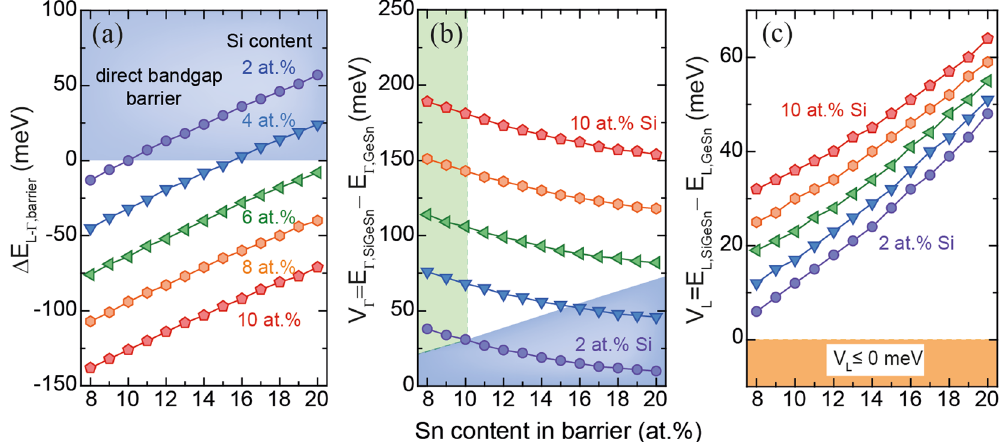
Figure 2. Directness of SiGeSn barrier ( a ), band discontinuity for Γ - ( b ) and L-valleys ( c ) for a Ge 0.92 Sn 0.08 / SiGeSn MQW for different Sn contents in the barrier. The colored areas indicate regions where SiGeSn is an indirect semiconductor (blue), band discontinuities for L are negative (orange), and which correspond to CVD realistic layers